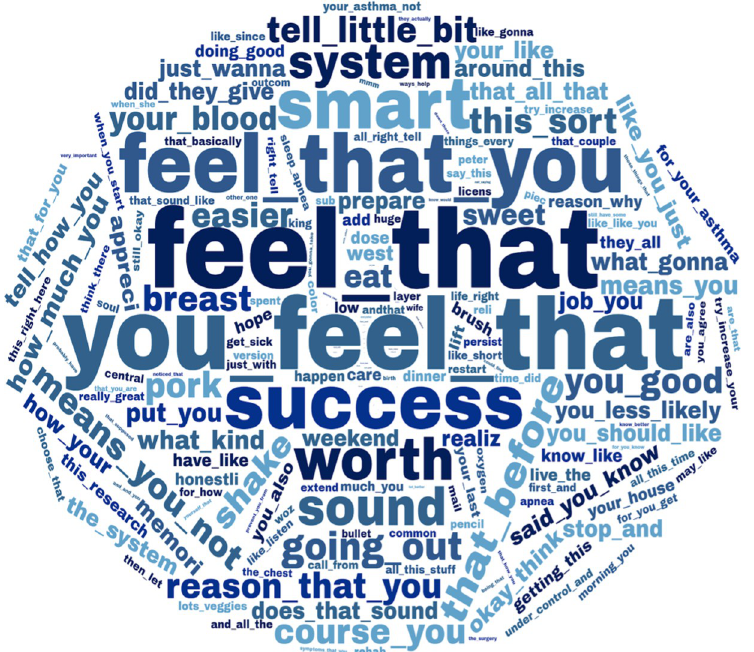
Fig 2. Words and expressions associated with higher levels of shared decision-making.